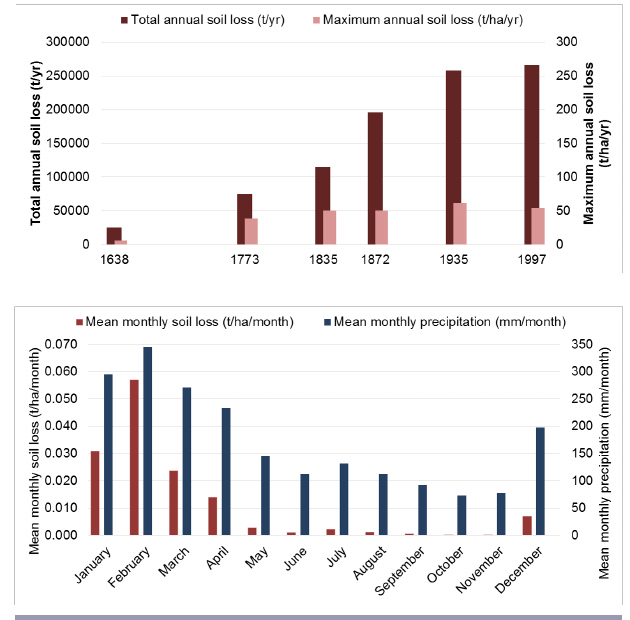
Fig. 5. Total annual modeled soil loss for the whole island (t/yr) and maximum value of modeled annual soil loss within the whole island (t/ha/yr) for each of the six analyzed timeslices (upper graph) and mean monthly modeled soil loss (t/ha/ month) for the 1638 timeslice and mean monthly precipitation (mm/month, lower